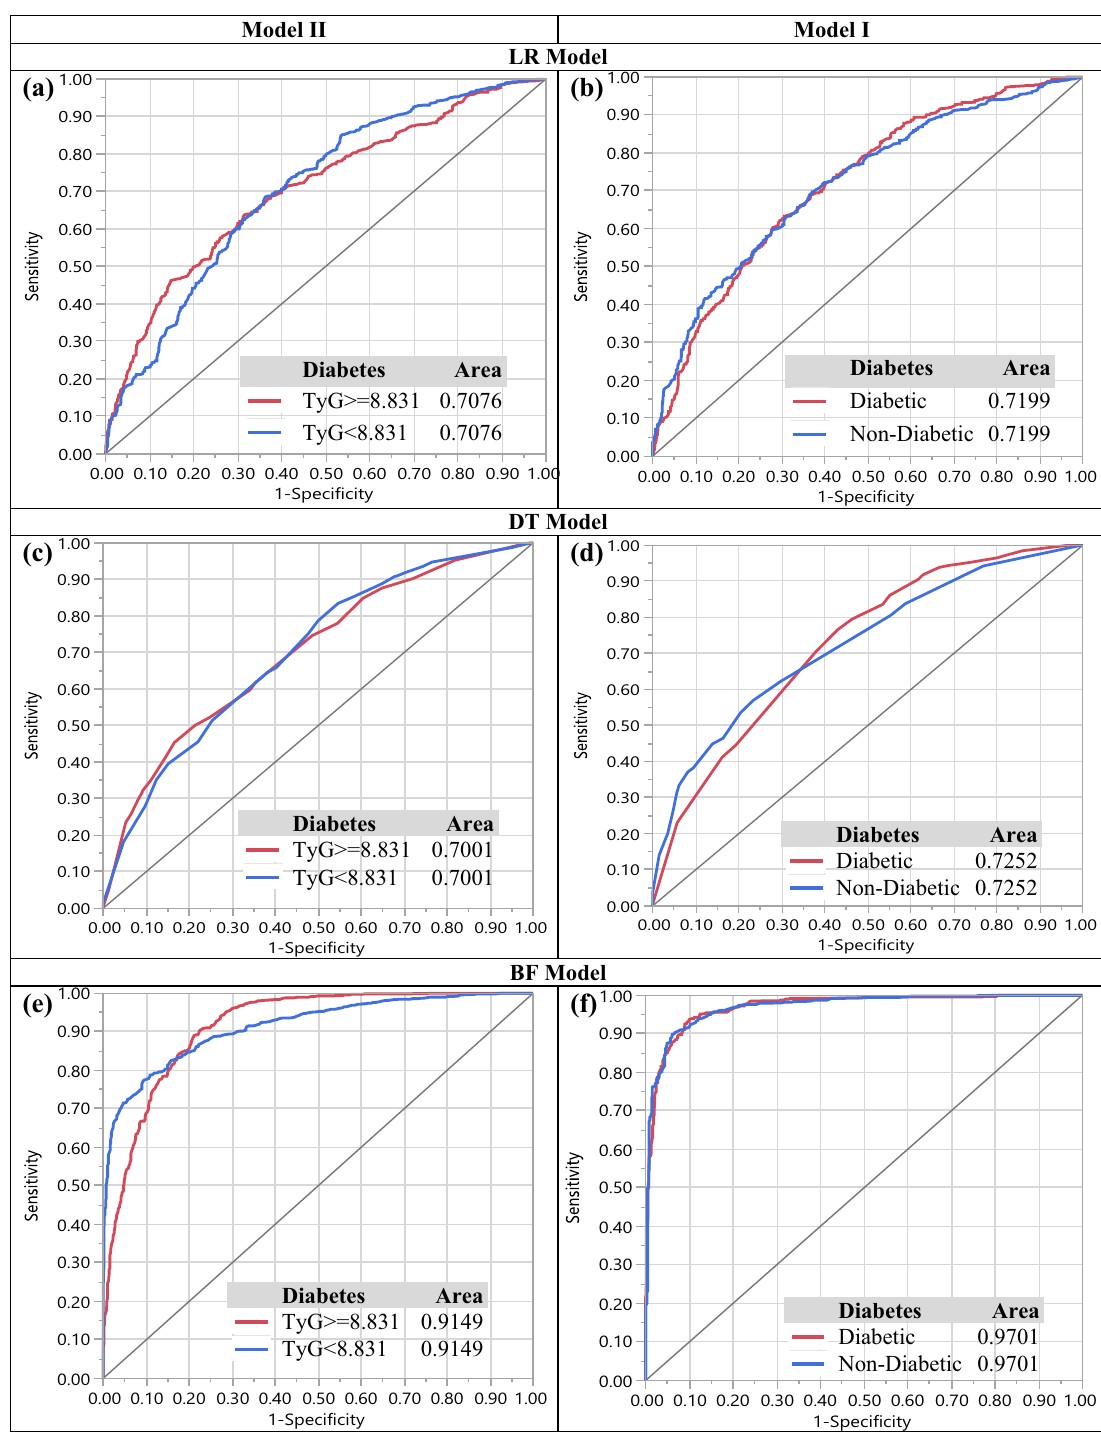
Figure 2. ROC curves for LR, DT, and BF algorithms for models I and II. Figures ( a , c and e ) show the ROC curves for LR, DT, and BF algorithms in model I. Also, figures ( b , d and f ) show the ROC curves for LR, DT, and BF algorithms in model